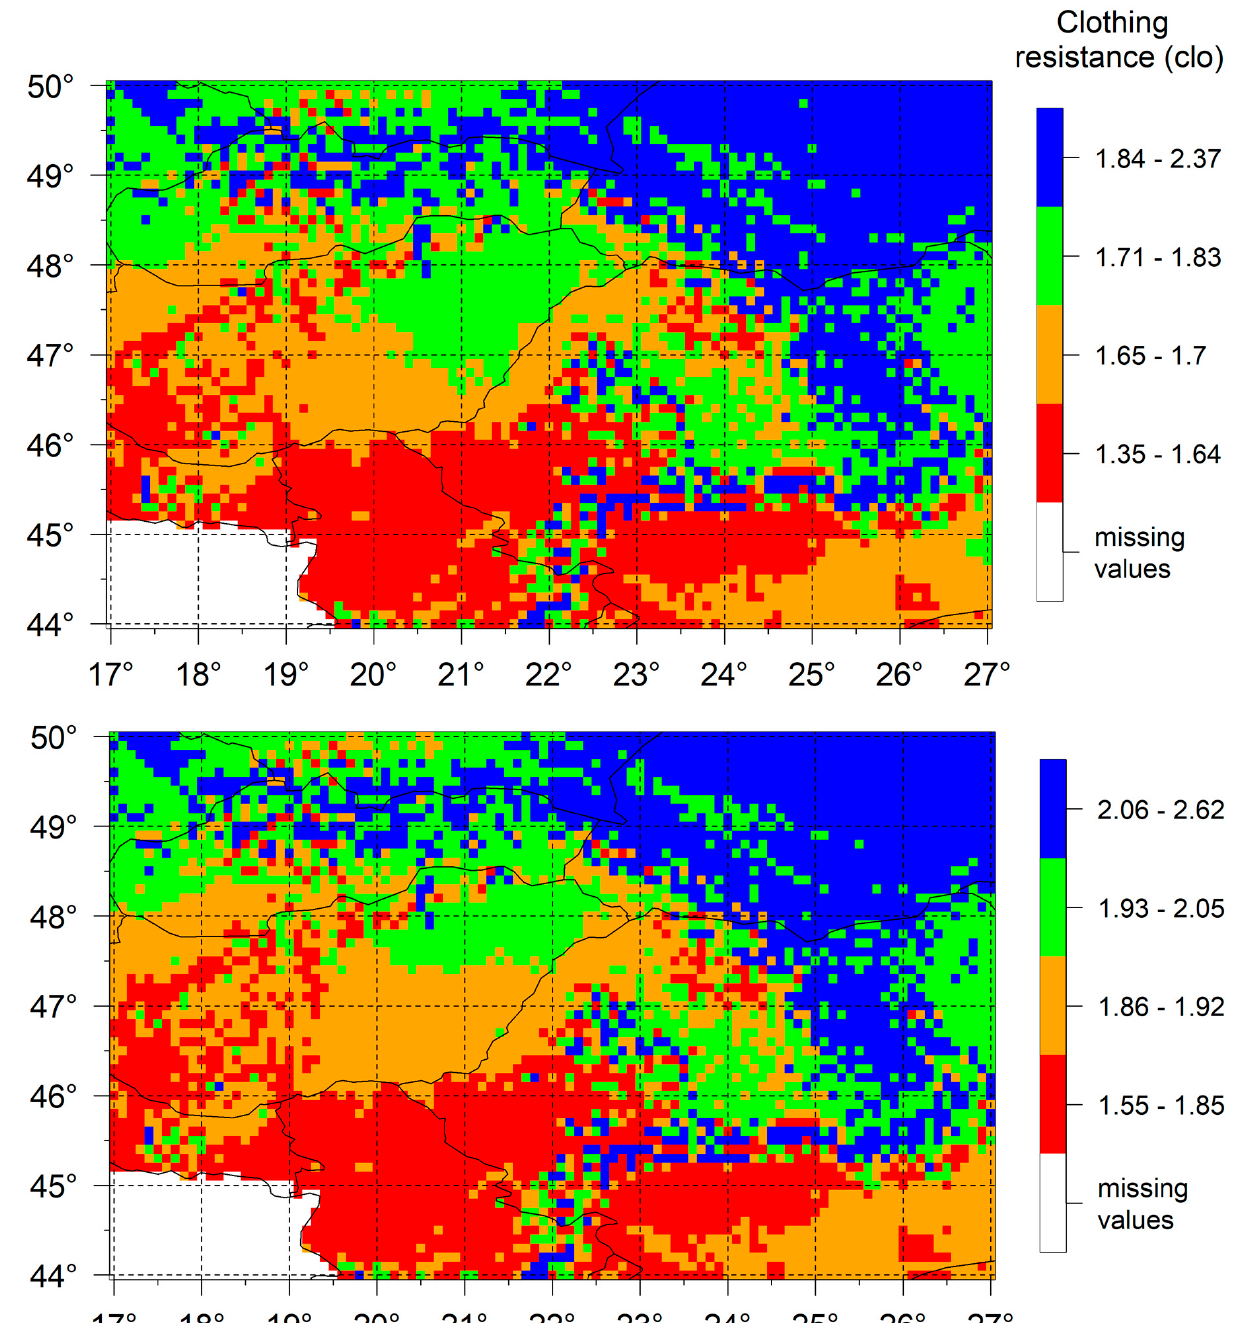
Figure 8. Spatial distributions of January clothing thermal resistance values obtained by using the new statistical deterministic scheme for persons 1 and 2 representing the average adult Hungarian male ( top ) and female ( bottom ) in the CarpatClim dataset region for the period 1971–2000. The same spatial distributions but for the month July are presented in Figure